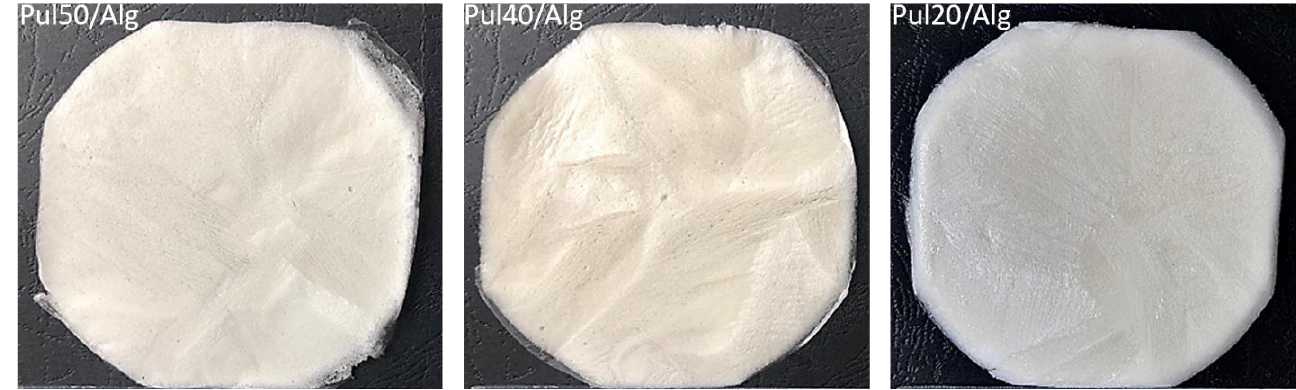
Table 2. Porous matrices composition for triamcinolone application.